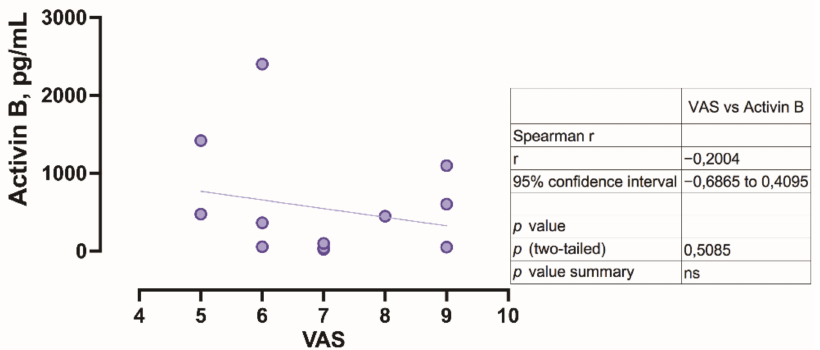
Figure 5. Correlation of visual analogue scale with activin B